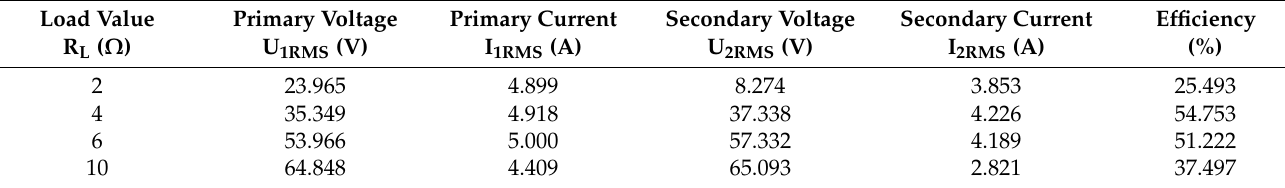
Figure 9. Measurements of system efficiency and secondary voltage as a function of load ( left ) and as a function of switching frequency ( right ) for 𝑅 𝐿 = 8 Ω . Due to the core losses, it is not possible to achieve a high TX and RX quality factor, and it is therefore advantageous to use a sine filter on the primary side, which will significantly reduce THDi. The successful operation of the system in an industrial device DMU 40 eVo linear is demonstrated in Figure 10.